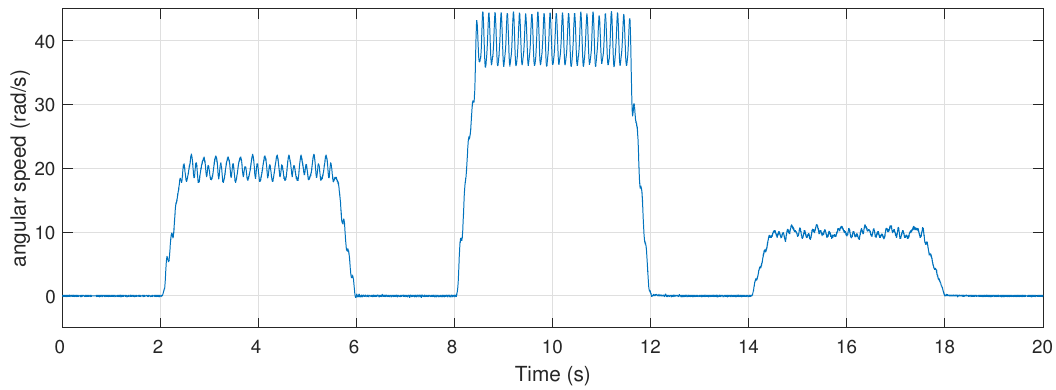
Figure 9. Experimental result: motor angular speed ω under the PI controller.